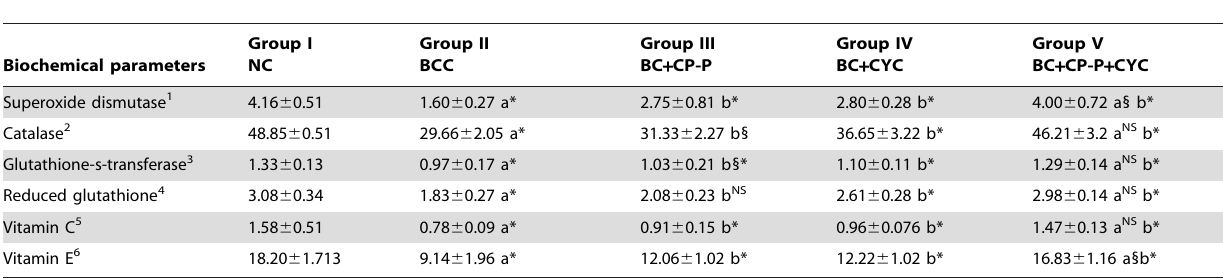
Table 1. The activities of antioxidant enzymes levels in breast tissue of control and experimental animals.